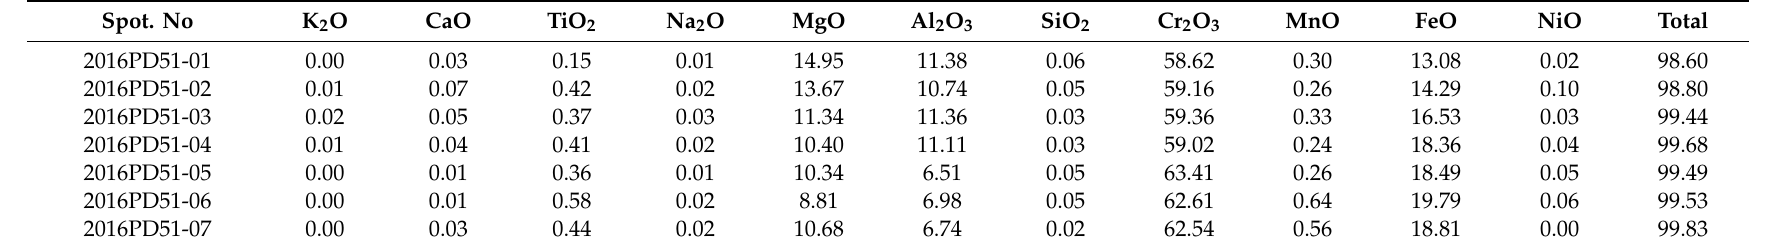
Table A4. Major element composition (wt.%) of spinel in Jijal